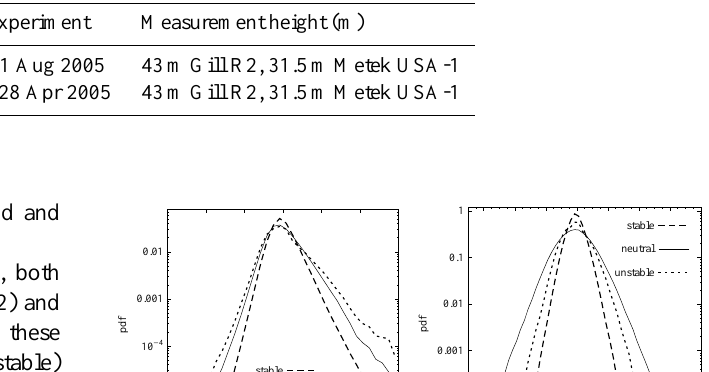
Table 1. Overview of experiments used for instrument intercomparison.